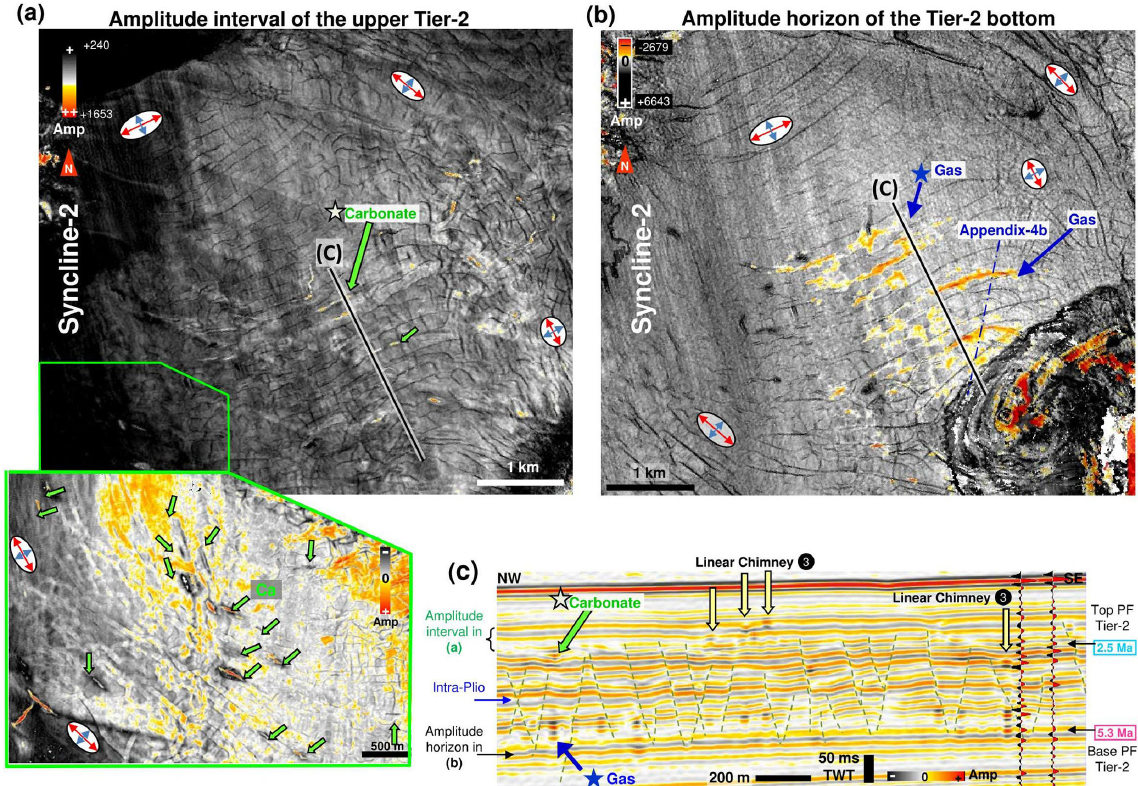
Figure 10. The linear planform of the topmost and lowest termination of chimney Type-3, and the alignment of the Linear Chimneys parallel to polygonal faults in withdrawal Syncline-2. (a) RMS amplitude extraction of a window in the upper portion of PF Tier-2 showing linear carbonates (red: positive high-amplitude anomalies, PHAAs). Exceptional examples of Linear Chimneys without preferential orientation can be observed close to the NE edge of the syncline (see carbonates on the right side of the image). See brackets in (c) for the vertical location. The blue axis and red axis on stress ellipses indicate the palaeo-orientation of the intermediate and minimum stresses, respectively. (b) Amplitude map of horizon at the base of PF Tier-2 showing the linear gas accumulations (red: negative high-amplitude anomalies, NHAAs). Note that NHAAs are aligned parallel to overlying PHAAs shown in (a) . (c) Seismic section showing positive bright spots (Ca for carbonate) above and negative bright spots below Linear Chimneys. Numbered black-filled circle indicates the type of chimney. Green arrows indicate the position of carbonates, while yellow ones indicate locations of Linear